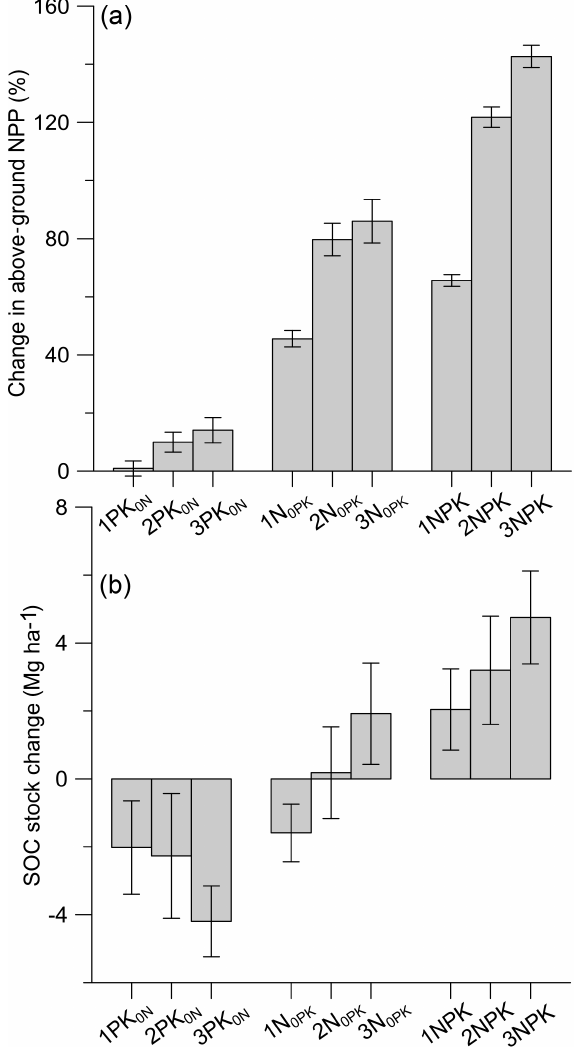
Figure 1. Average relative yield differences (a) and average soil organic carbon (SOC) stock differences (b) between fertilised and unfertilised soils for all investigated levels of fertilisation (PK 0N , N 0PK , NPK) with standard